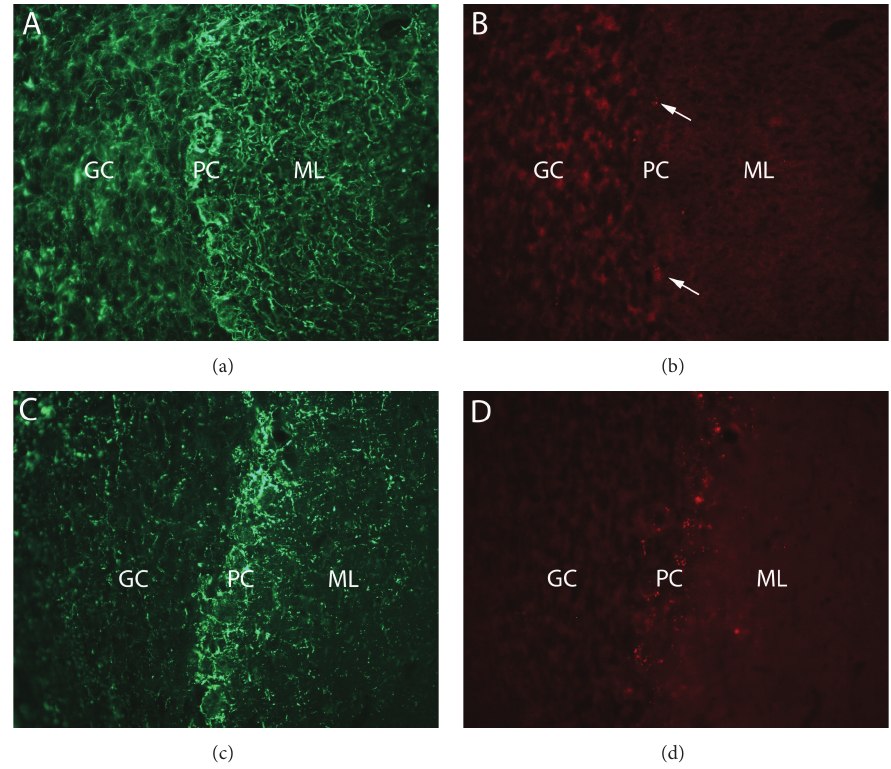
Figure 2: Photomicrographs (40x objective) of SMI-31 ((a) and (c)) and synapsin-1 ((b) and (d)) staining in sham ((a) and (b)) or 42-day SCI cerebellum ((c) and (d)). Note the loss of SMI-31 staining in the molecular layer (ML), as well as the pronounced synapsin-1 staining in the Purkinje cell (PC) layer in the 42-day SCI cerebellum ((c) and (d)).